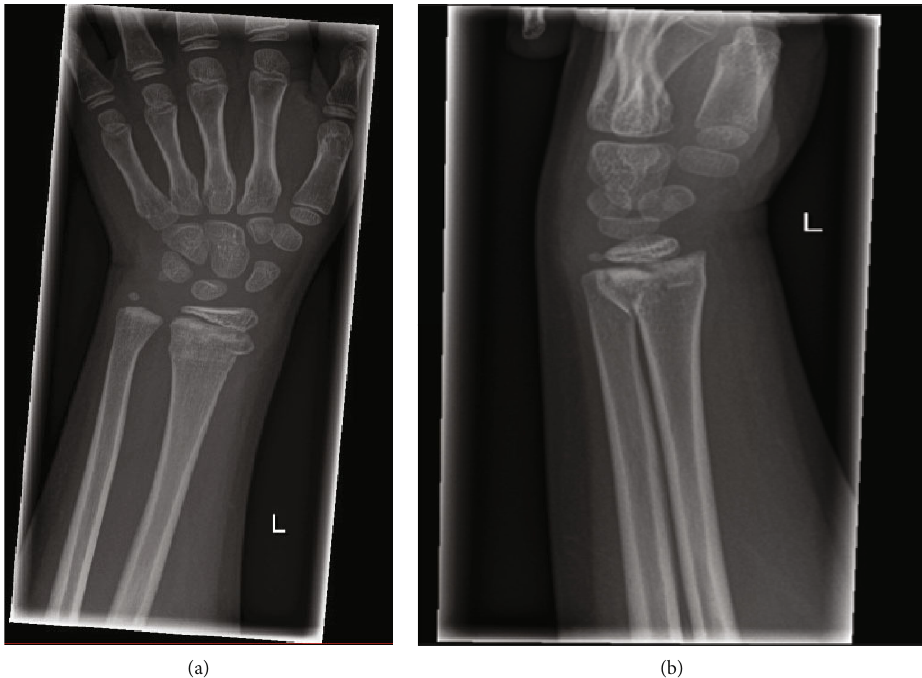
Figure 3: (a, b) Anteroposterior and lateral radiographs of the left wrist distal forearm fracture showing a Salter-Harris type 2 fracture of the distal radius and a greenstick fracture of the distal